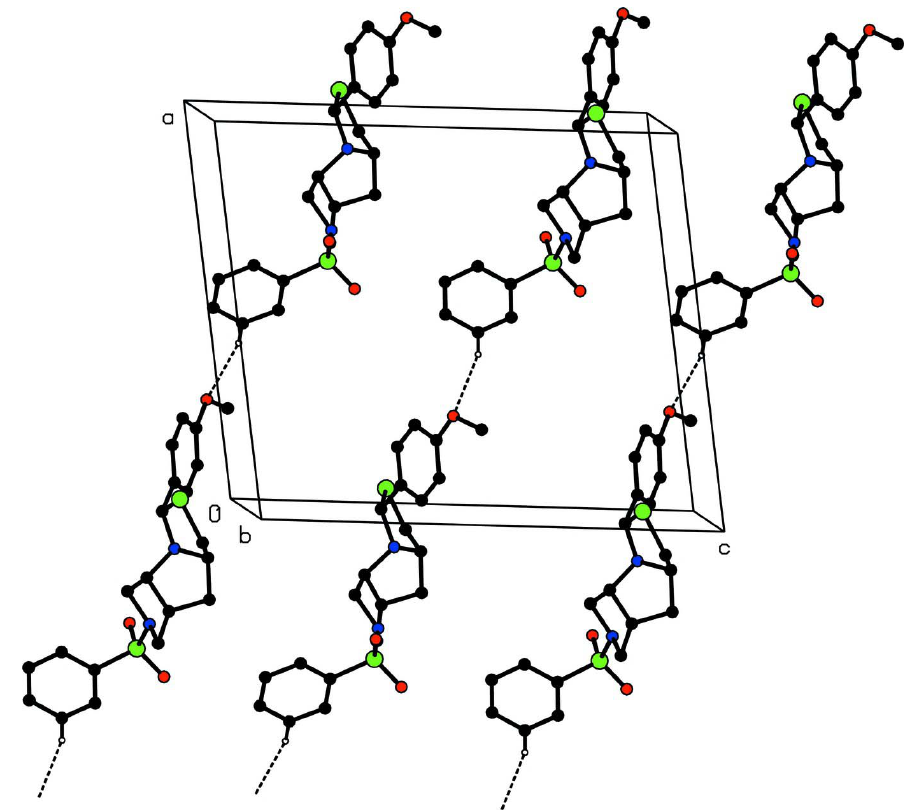
Figure 2 The crystal packing of the title compound viewed down the b